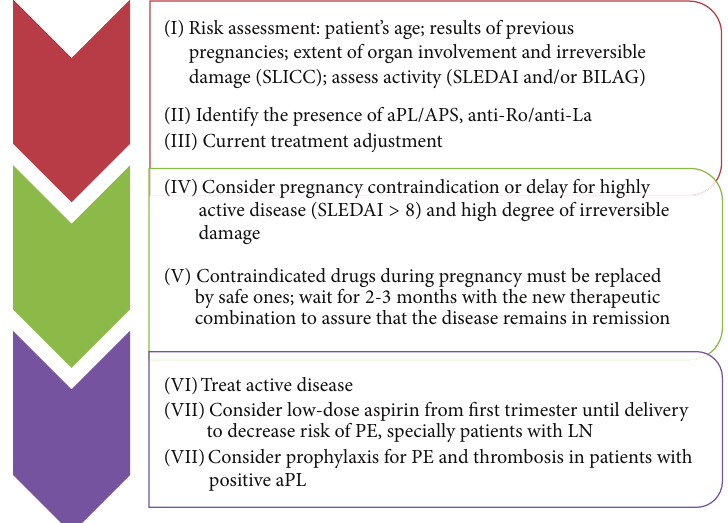
Figure 2: Counselling and pregnancy planning for patients with